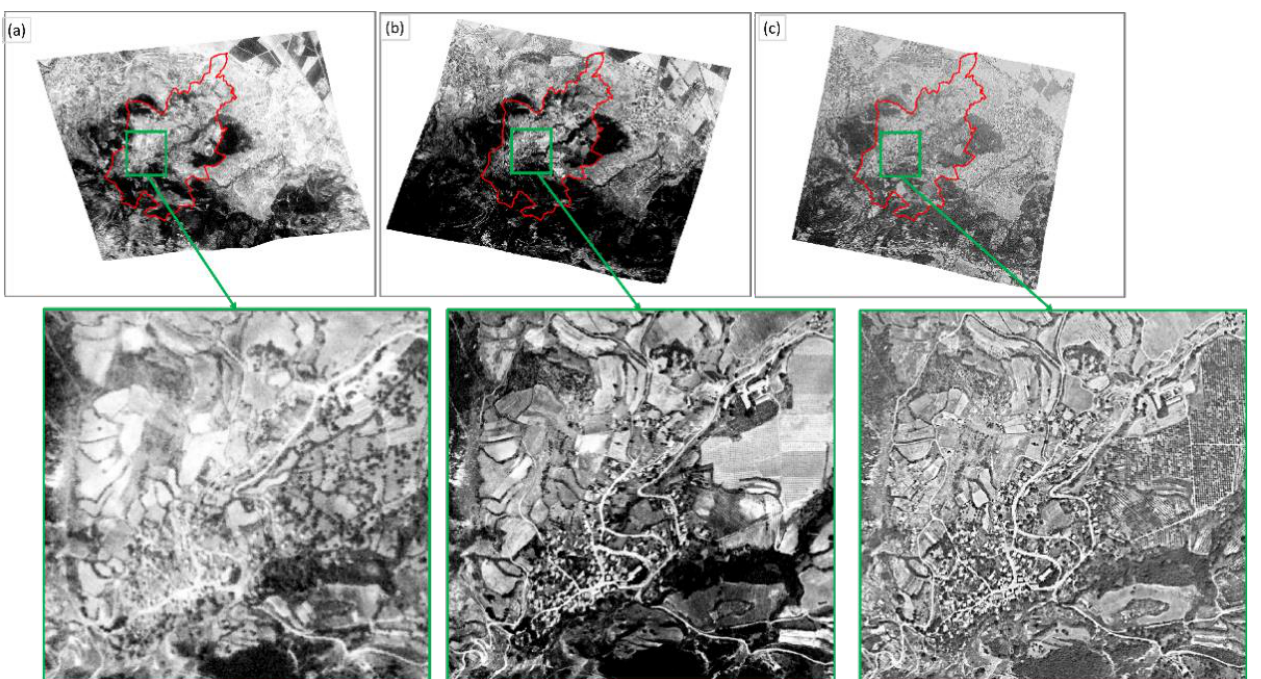
Figure 10. Ruen village captured by ( a ) Corona image from 1968, ( b , c ) Hexagon images from 1975 and 1980, respectively (finer details of the region from Ruen village center are shown in the inset images highlighted by green boxes). Red vector illustrates the boundaries of the Stamboliyski town.